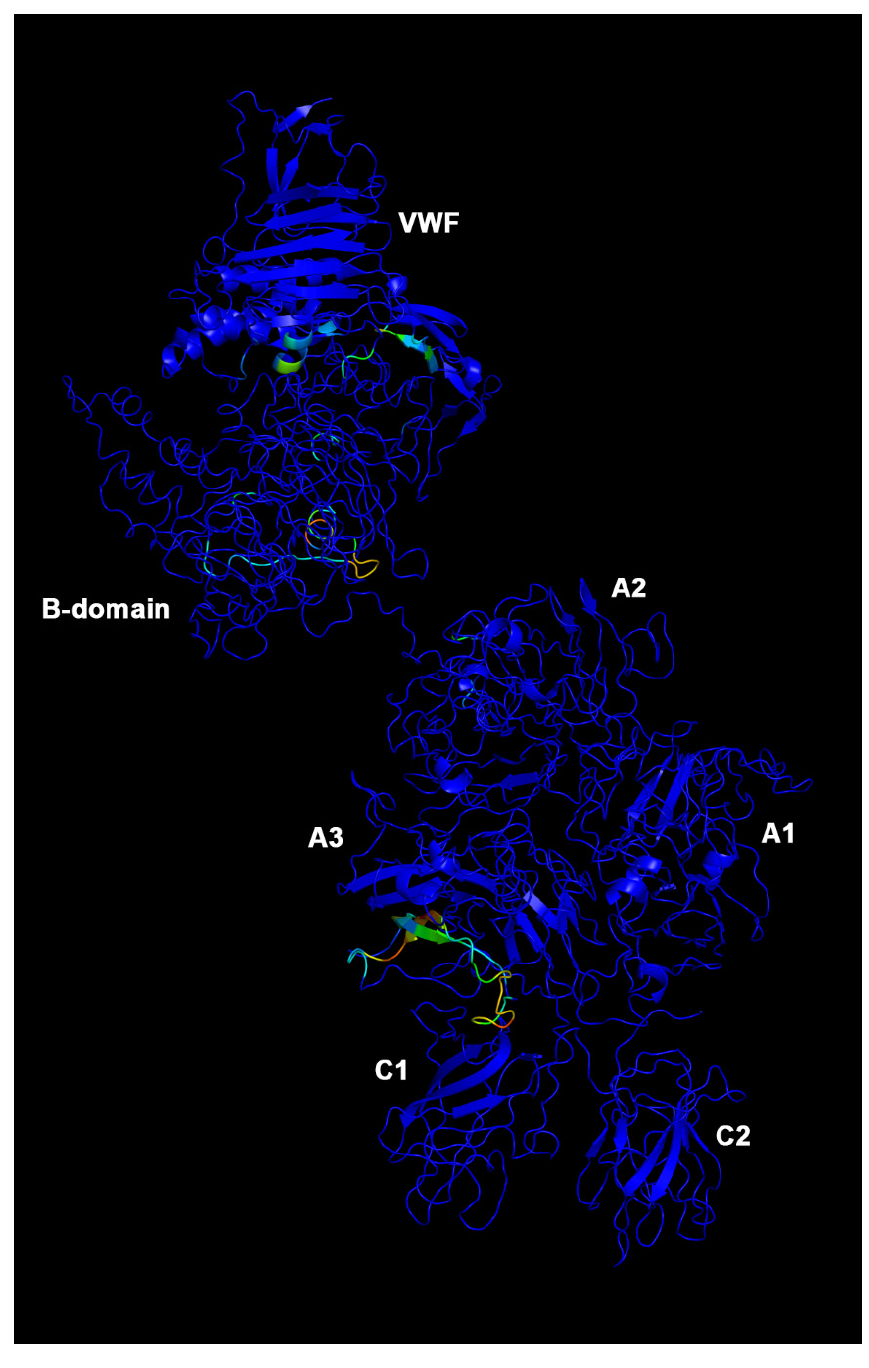
Figure 5. VWF/FL-FVIII complex allosteric residues. Participation coefficient P heat map in color scale (blue to red, increasing values of P ). Blue residues have a P = 0. Capital letters refer to protein domains of FVIII.